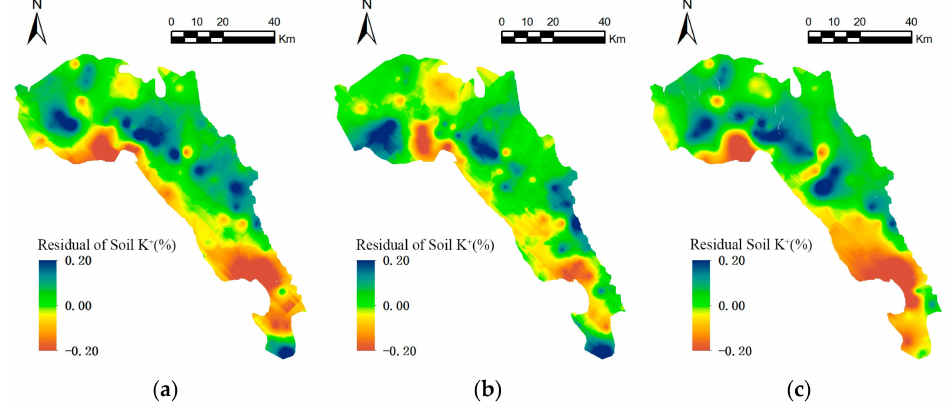
Figure 6. Residual surfaces r(x mn ,y mn ) of soil K + for different secondary variables: ( a ) land use; ( b ) geology; ( c ) soil